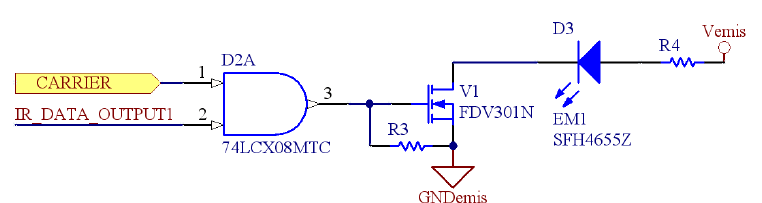
Figure 5. Schematic of one emission